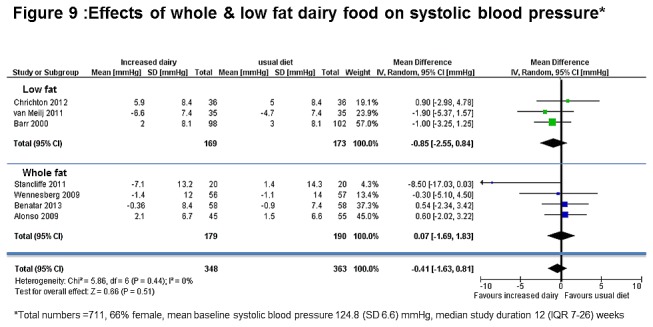
Effects of whole & low fat dairy food on systolic blood pressure.